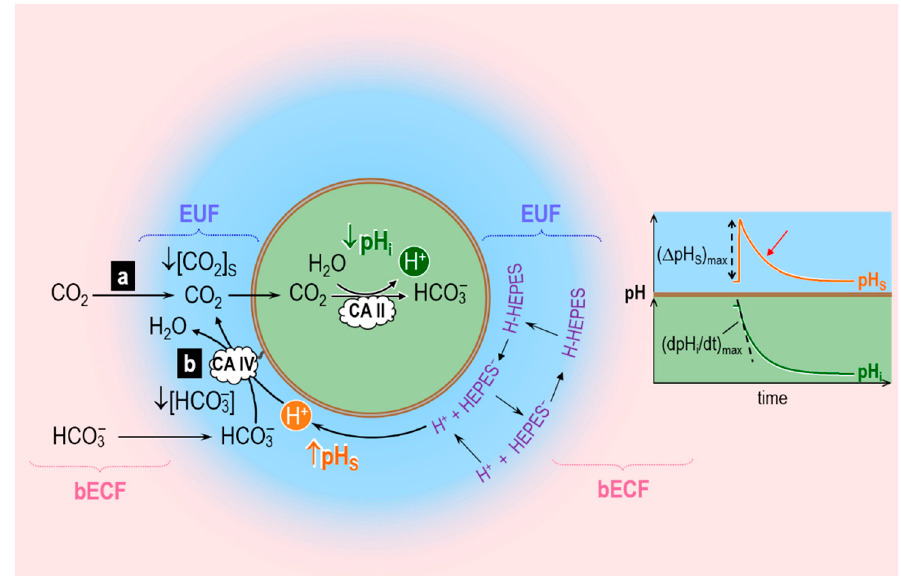
Figure 4. Reaction and diffusion events caused by influx of CO 2 into a cell (an oocyte) and effect on extracellular-surface pH (pH S ) and intracellular pH (pH i ). Here, the influx of CO 2 into the cell creates a CO 2 sink at the outer surface of the membrane, ↓ [CO 2 ] S . The two insets show the time courses of pH S and pH i during the CO 2 influx. bECF, bulk extracellular fluid; EUF, extracellular unconvected fluid; CA, carbonic anhydrase. Modified from Figure 1 of [78].